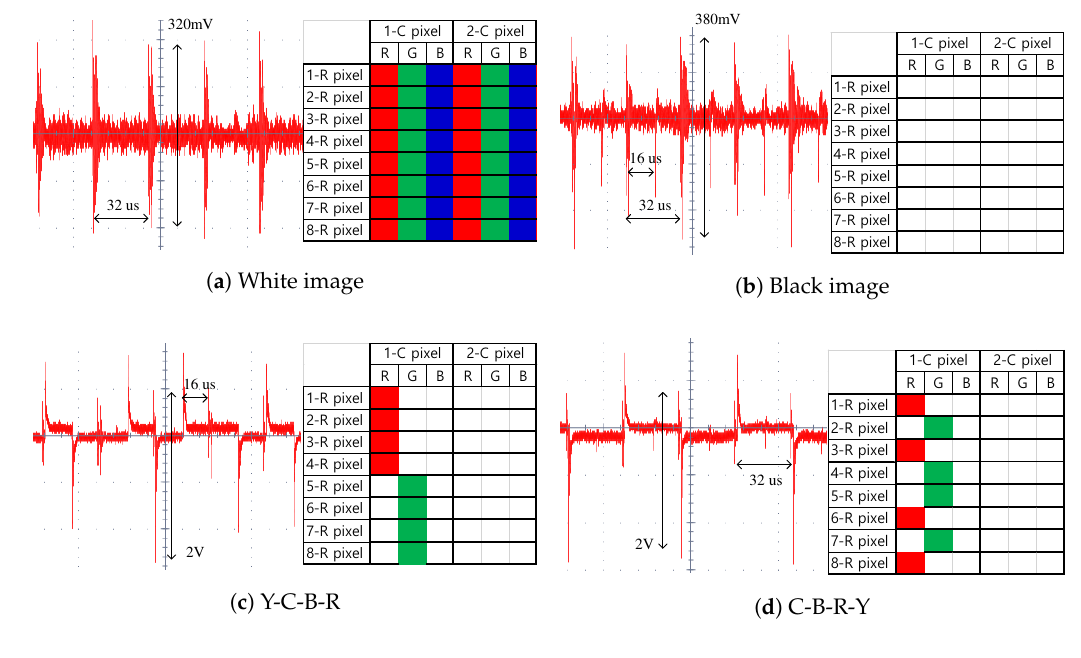
Figure 12. Display noise patterns in eight rows and two adjacent pixel columns induced by four different images; a white blank means “off state”, and all colored squares denote “on state” in RGB